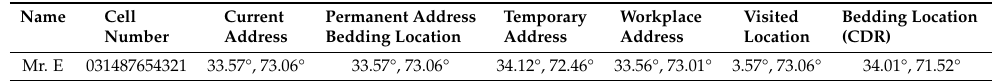
Table 8. Information gathered from the proposed